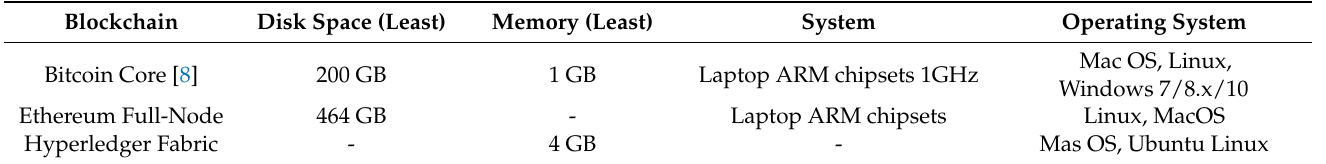
Table 1. Minimum requirements for representative blockchain